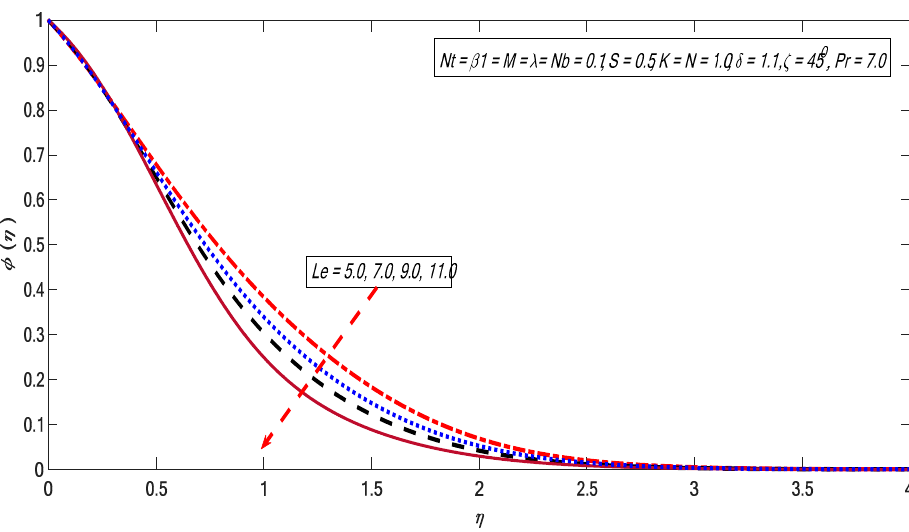
Figure 19. Variations in concentration profile for several value of 𝐿𝑒 .